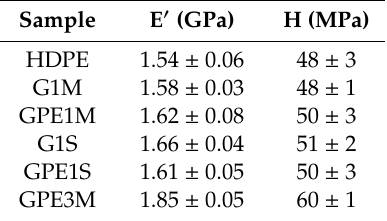
The curves showing the evolution of the gas transport as a function of time exhibit a transient zone at short time followed by a region at long times in which the pressure is a linear function of time. An illustrative plot of the variation of the pressure p ( t ) of oxygen, nitrogen, and carbon dioxide in the downstream chamber as a function of time in the GPE1M membrane is represented in Figure